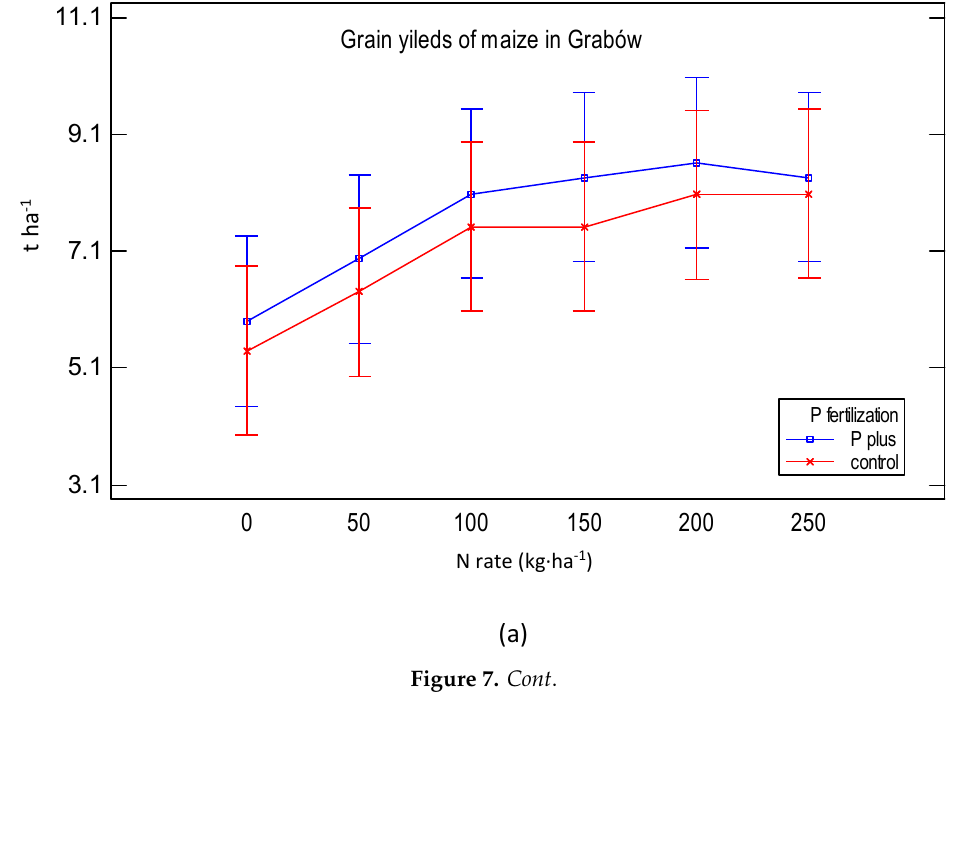
(b) Figure 7. Grain yields of maize at increasing additions of N fertilizer at the P-plus and control levels of P; 95% Tukey HSD intervals; n = 384 for each location (P fertilization (a) Grabów HSD 1.183, (b) Baborówko HSD 0.894).